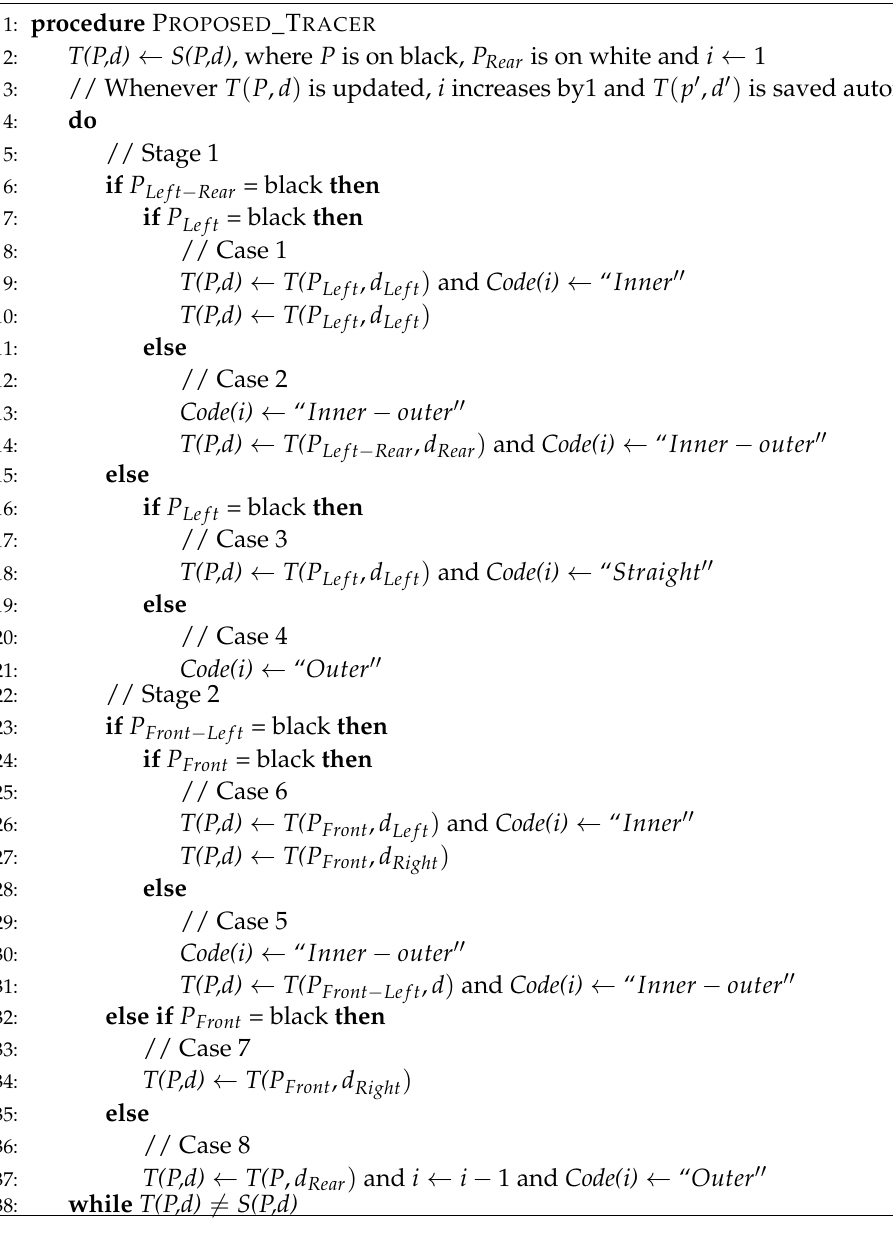
Algorithm 3 Procedure of the proposed